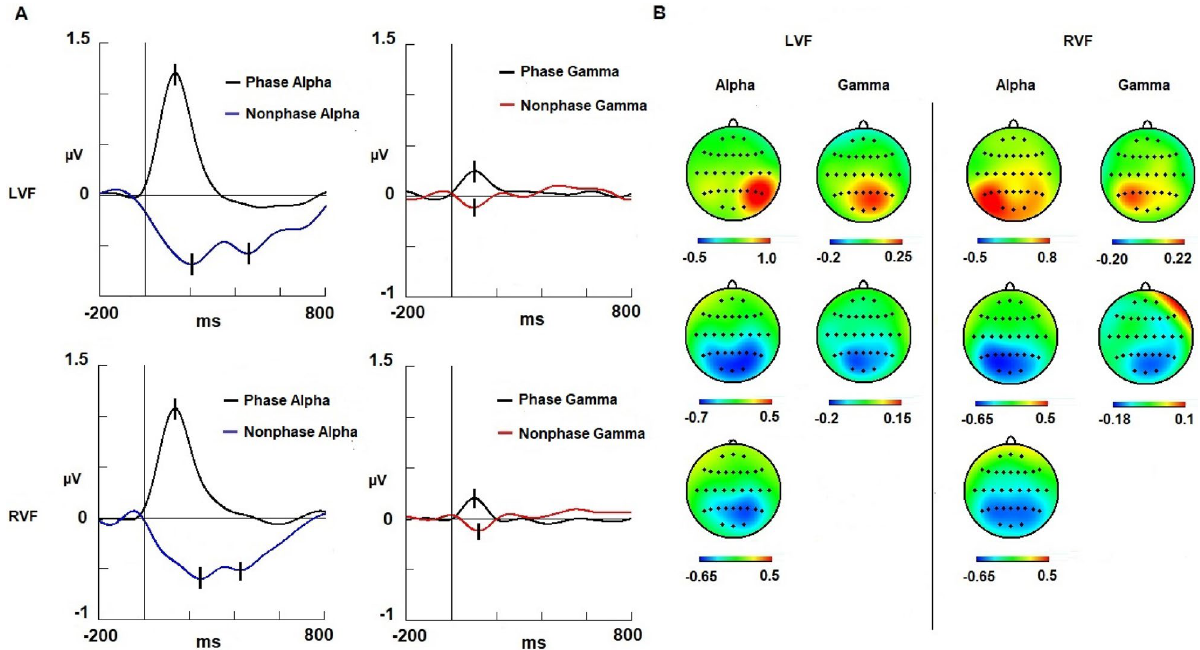
Figure 4. Modulations and topographic maps of the alpha and gamma bands. Spectral activity of the alpha and gamma bands. ( A ) Alpha and gamma modulations are represented in the left column and right column, respectively. ( B ) The upper row represents evoked activity maps for alpha and gamma; the second row shows the first valley of the induced activity maps (alpha and gamma); and the third row displays maps of the second valley of the alpha-induced activity. Nonphase-locked alpha activity was more bilaterally represented than phase-locked activity. The phase-locked gamma response was contralateral and synchronized, whereas nonphase-locked gamma activity was desynchronized in the ipsilateral derivations. Abbreviations LVF left visual field, RVF right visual field, ms milliseconds, µV microvolts.